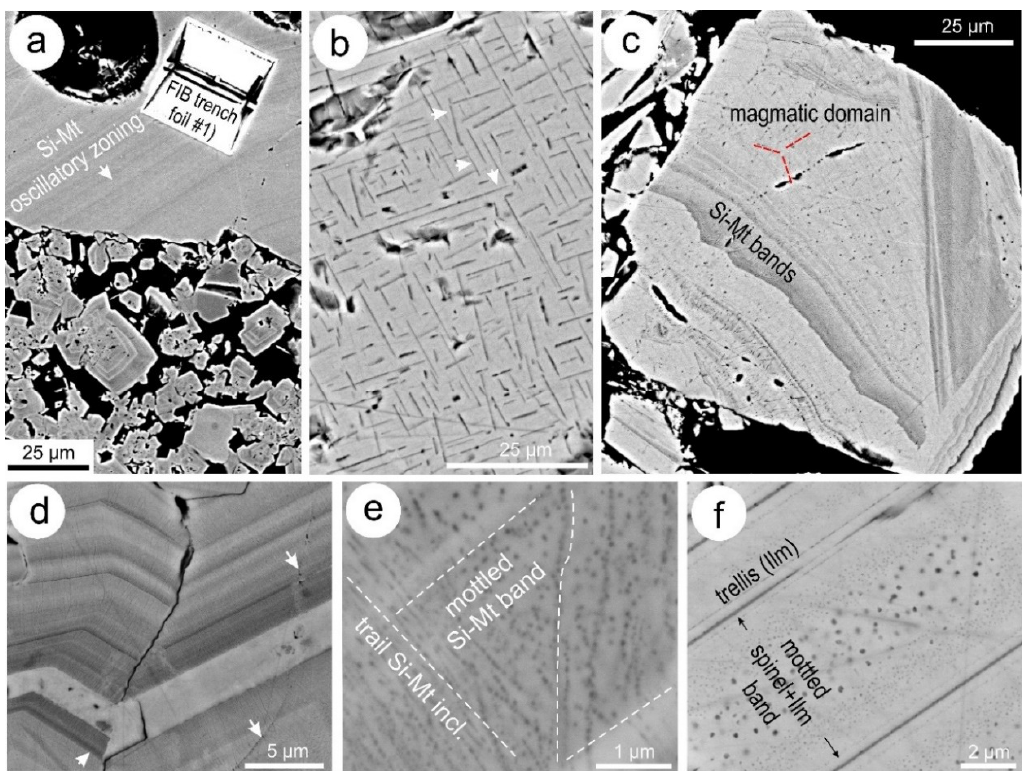
Figure 2. BSE images showing magnetite textures. ( a ) Coarse (>500 µm) grain surrounded by small (a few µm to some tens of µm) grains of silician magnetite (Si–Mt) typical for the massive magnetite interval (location #1, Figure 1b). ( b ) Trellis exsolutions (white arrows) in magmatic magnetite from RDG (location #5, Figure 1b). ( c ) Fragment of magnetite with magmatic domains superimposed by banded silician magnetite (location 5, Figure 1b). ( d ) Overprint of oscillatory zoning in silician magnetite observed as microfracturing and displacement of bands (white arrows). Mottled textures in silician and magmatic magnetite in ( e ) and ( f ), respectively. Note trails crosscutting crystal zoning in ( e ) and variation in inclusions size across any given band between sets of trellis exsolutions marked by ilmenite (Ilm).